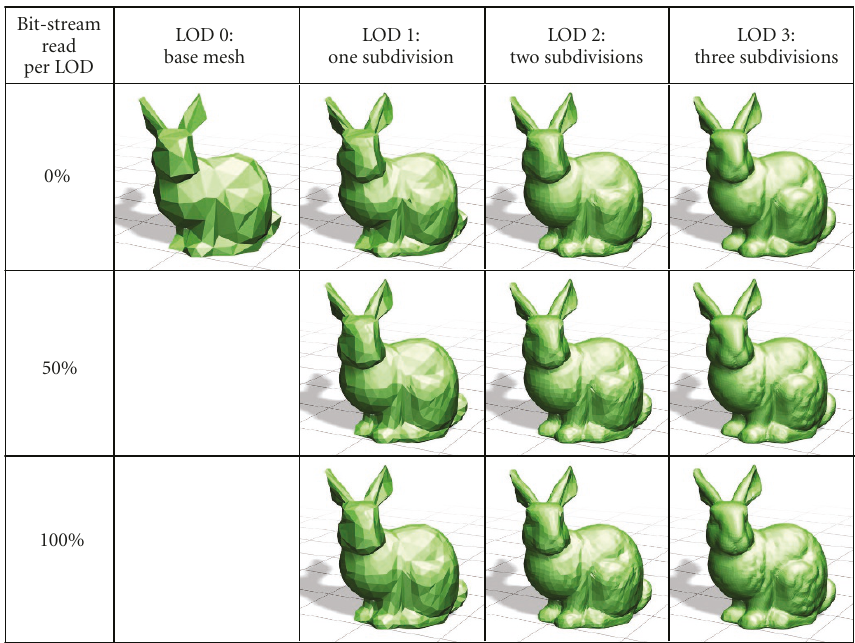
Table 1: Progressive reconstruction of the bunny model from a PLTW